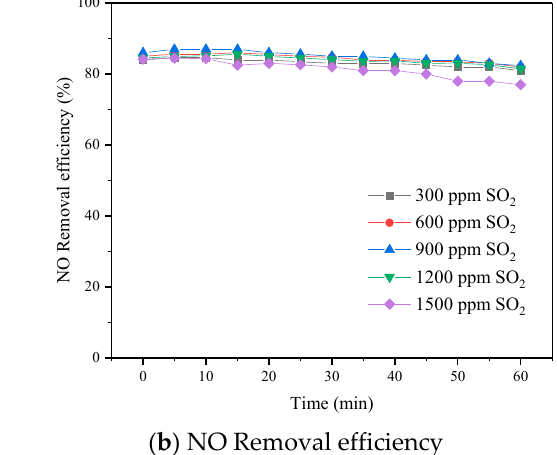
Figure 5. Effect of inlet SO 2 concentrations on desulfurization and denitration ([NO], 200 ppm; n O /n NO , 1.2; inlet gas temperatures 200 ◦ C; artificial seawater, 30 L). 3.5. The Influence of pH and Mechanism Analysis of Desulfurization and Denitrification In the spraying tower, No is oxidized to a high valence mixture (NO 2 , and N 2 O 5 ) by O 3 , and then, NO 2 , N 2 O 5 , and SO 2 are absorbed by the seawater solution (The flow rate of the spraying nozzle was about 1 L·min − 1 ) 30 L. The initial pH value of artificial seawater was 8. The cyclic seawater solution temperature is kept at 50 °C by a water bath. The inlet concentrations of NO and SO 2 are 300 and 1000 ppm, respectively; n O /n NO are 1.2. The absorption time is 60 min. pH values, desulfurization, and denitrification efficiency were recorded at intervals of 1 min to 5 min. The experimental results are shown in Figure 6. As shown in Figure 6, the pH gradually decreases from 8 to 7.11 before 25 min. Be- tween 25 and 40 min, the pH decreases rapidly from 7.11 to 4.13. After 40 min, the pH goes down to 3.97.